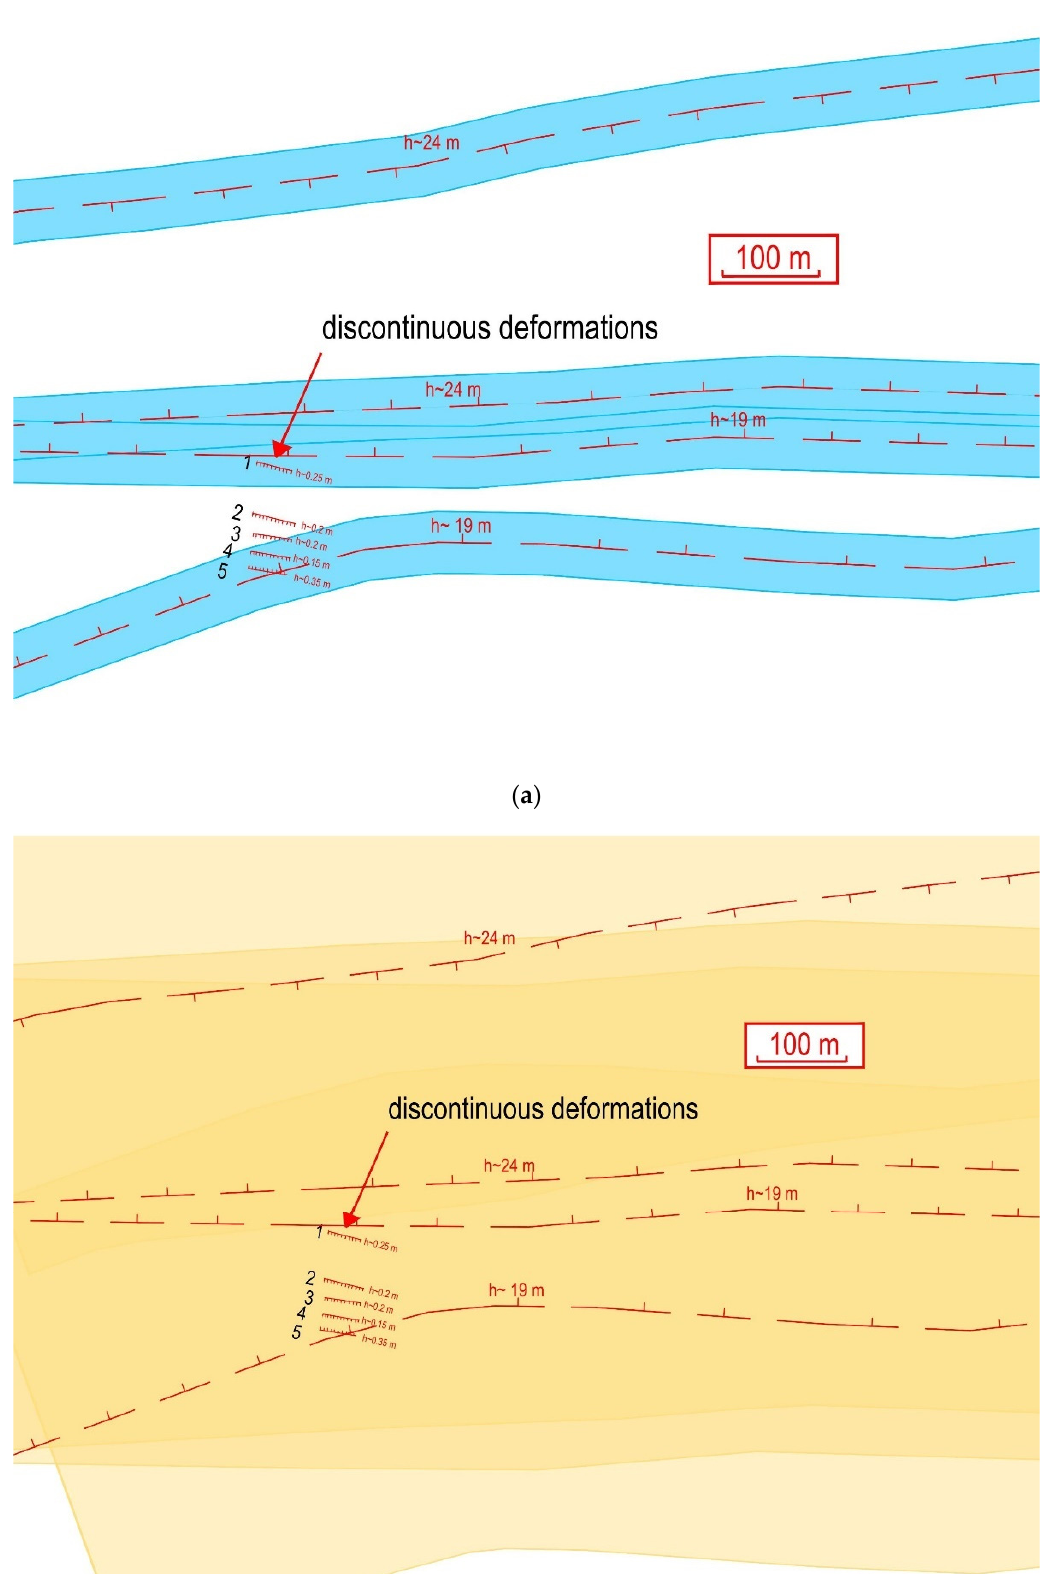
Figure 14. The zone threatened by occurrence of discontinuous deformations in the area of fault outcrops ( a ) S 1 , ( b ) S 2 calculated from Equation (4). outcrops ( a ) S 1 , ( b ) S 2 calculated from Equation